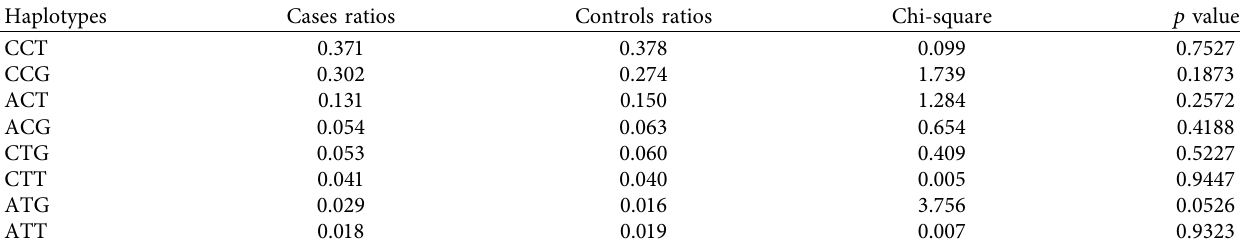
Table 4: Haplotype allele analysis of CSMD1 gene.